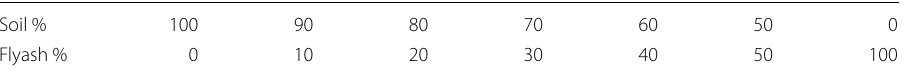
Table 1 Proportions of the mixed